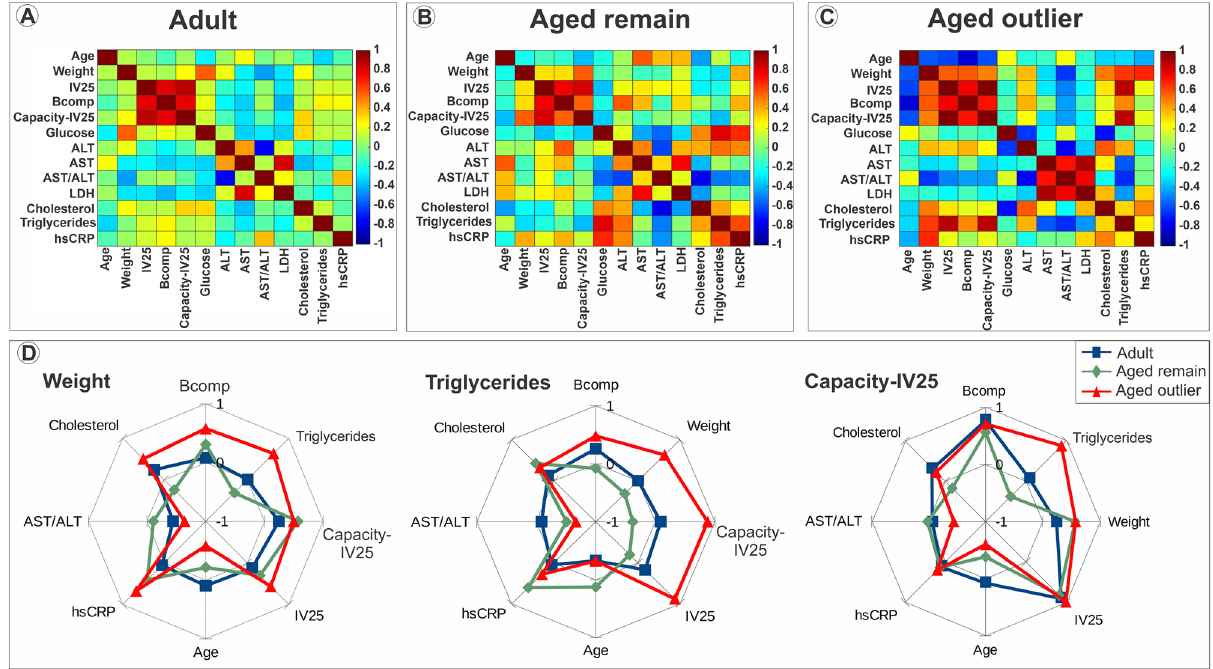
Figure 6. Correlation matrix for demographic, urodynamic, and metabolic outcomes. Heat map display shows correlation pairs across multiple demographic, urodynamic, and metabolic outcomes, including age, weight, IV25, Bcomp, Capacity-IV25, glucose, ALT, AST, AST/ALT ratio, LDH, cholesterol, triglycerides, and hsCRP ( A – C ). Note a higher number of pairs with strong correlations for the aged outliers compared to adult and aged remain groups ( C ). Radar plot displays to show correlations between weight, triglycerides, and Capacity-IV25 with multiple outcome measures, including also age, Bcomp, IV25, cholesterol, AST/ALT, and hsCRP ( D ). A positive or negative correlation over 0.5 is considered a strong correlation. Weight, triglycerides, and Capacity-IV25 showed mostly modest correlations with the other markers for the adult and aged remain groups, whereas weight, triglycerides, and Capacity-IV25 showed multiple strong correlations with other markers of detrusor underactivity and metabolic syndrome, including IV25, Bcomp, AST/ALT ratio, and hsCRP ( D